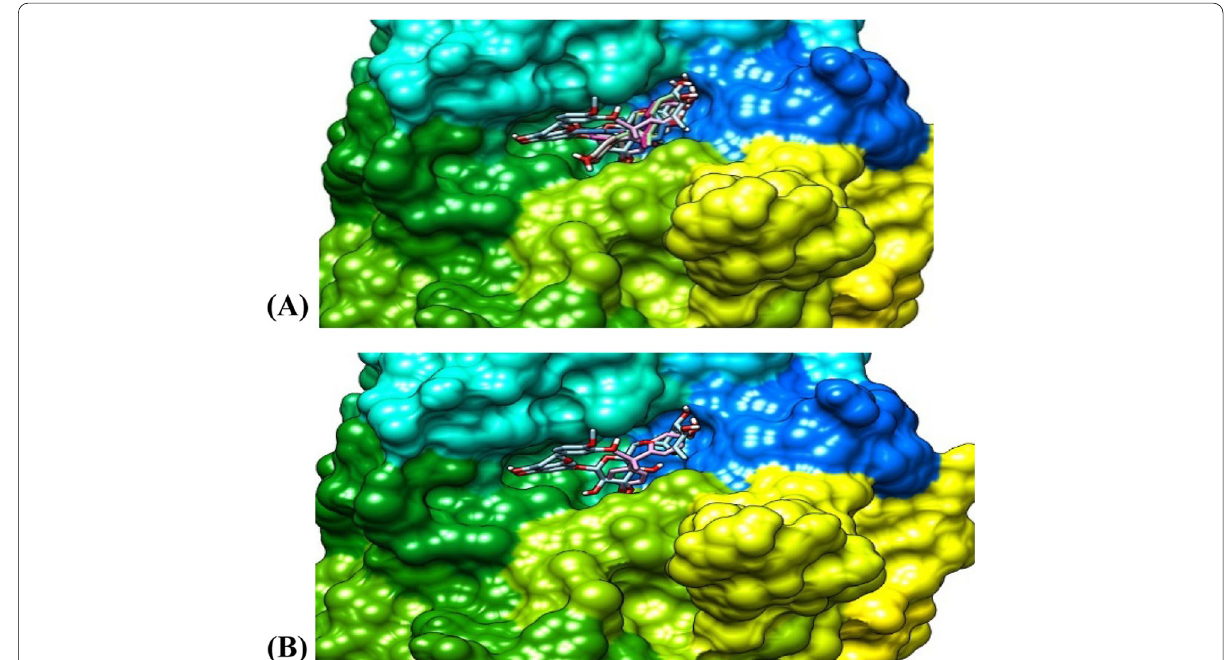
Fig. 5 The binding pose of the ligands at the same binding site of α-amylase. (A) . The best model of hesperidin in complex with 7 models of bisphenol A. (B) The binding pose of the best conformation/models of the ligands and the protein